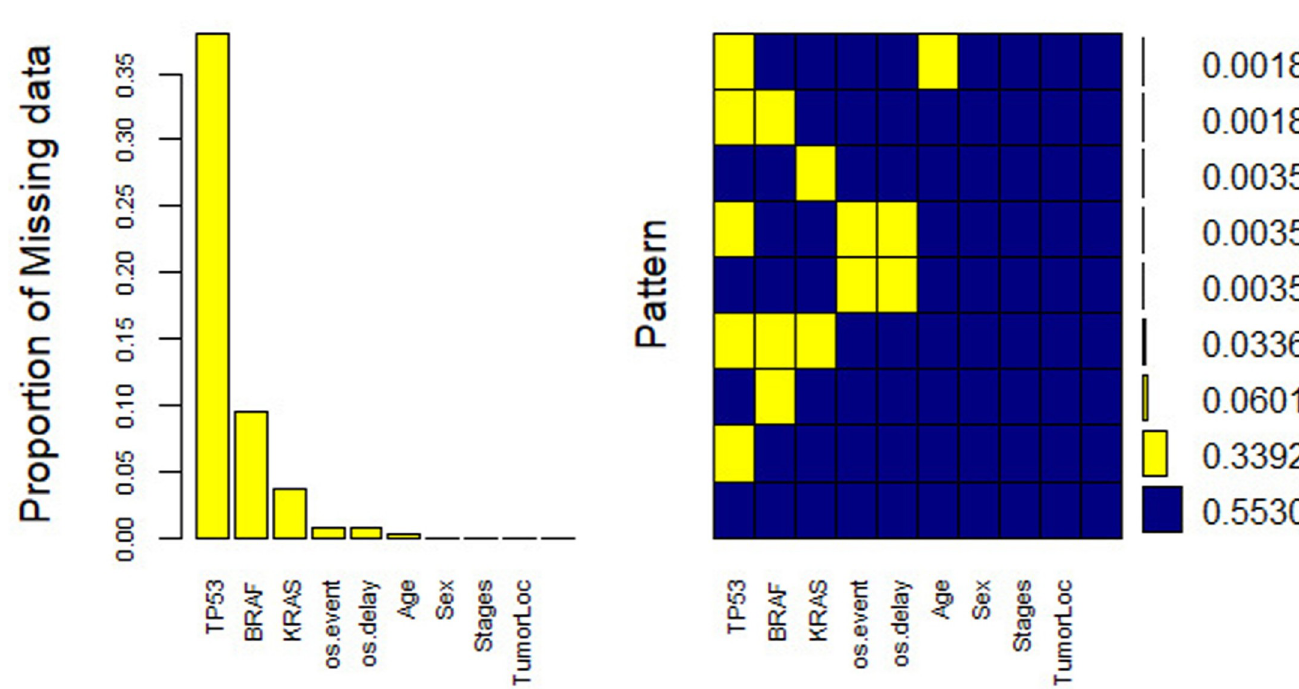
Fig 2. Proportion and patterns of missing values in the clinical characteristics available in the GSE39582 dataset.